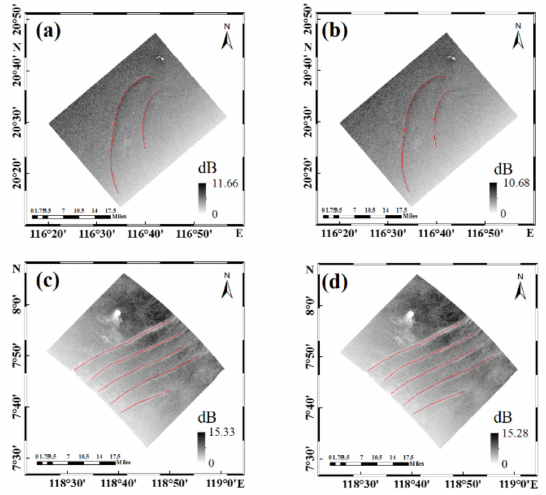
Figure 2. Examples of InIRA images obtained by Tiangong-2, the red solid lines are the crest lines of ISWs: ( a , b ) UTC 23 September 2016, South China Sea; ( c , d ) UTC 1 June 2018, Celebes